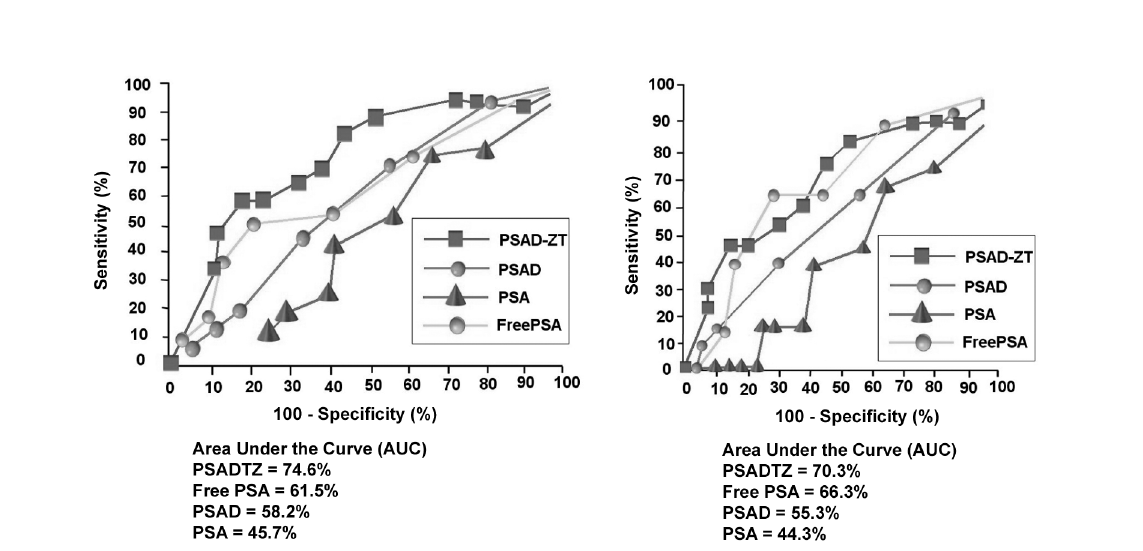
Figure 2 – Comparison of ROC curves with specification of AUCs in the general (left) and negative digital rectal examination (right) groups. PSAD-ZT = PSA density in the transition